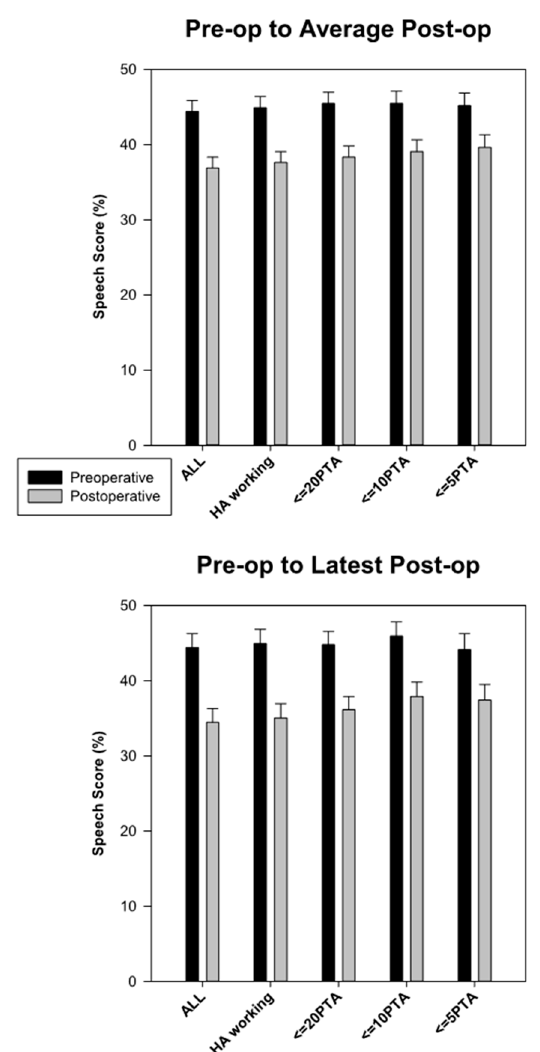
Figure 3. Postoperative speech perception scores in the nonimplanted ear are lower than preoperative scores even after excluding subjects whose hearing aid functioning could not be verified, or after excluding datapoints from subjects who showed decreases in pure-tone average greater than 20, 20, or 5 dB. The top panel compares preoperative data to average postoperative data and the bottom panel compares it to the latest available postoperative data.